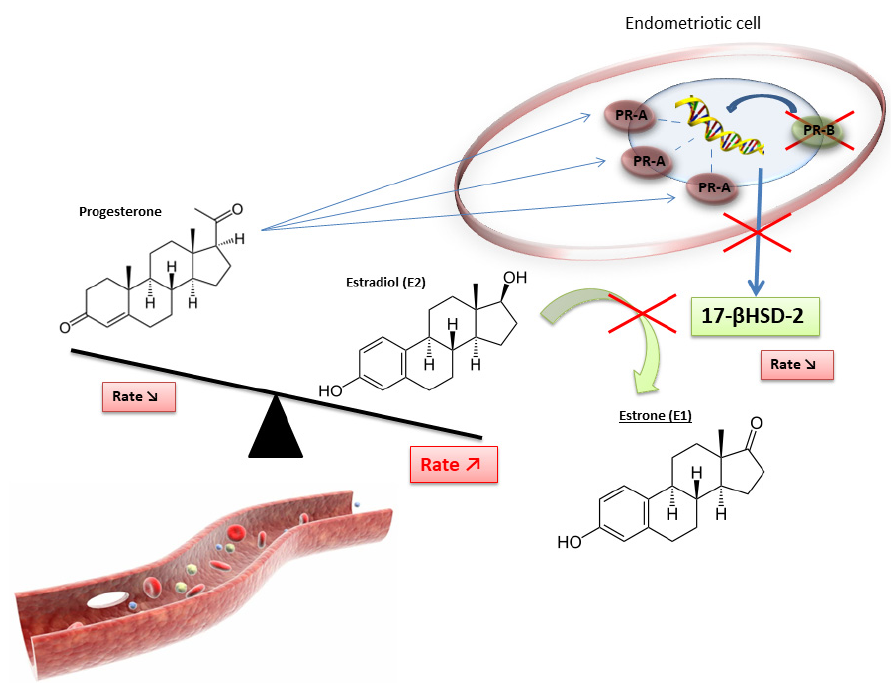
Figure 3. Disruption of progesterone/estradiol balance in endometriosis [4].